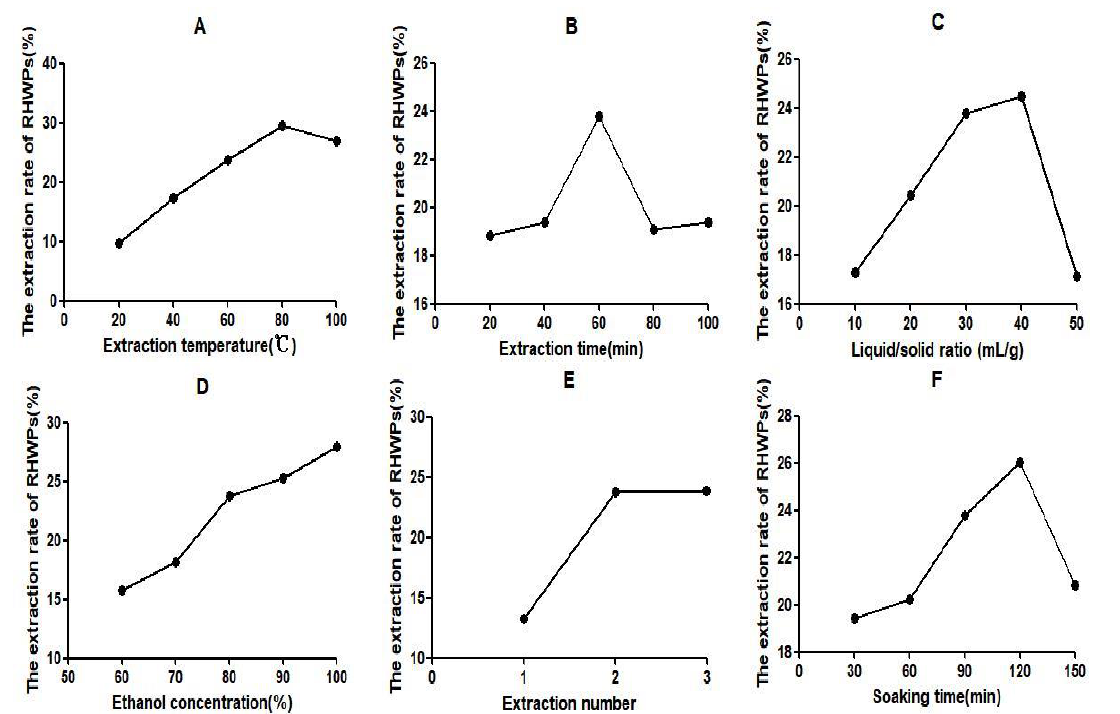
Figure 1. Effects of different extraction temperatures ( A ), extraction time ( B ), liquid/solid ratio ( C ), ethanol concentration ( D ), extraction number ( E ), and soaking time ( F ) on the extraction rate of RHWPs.